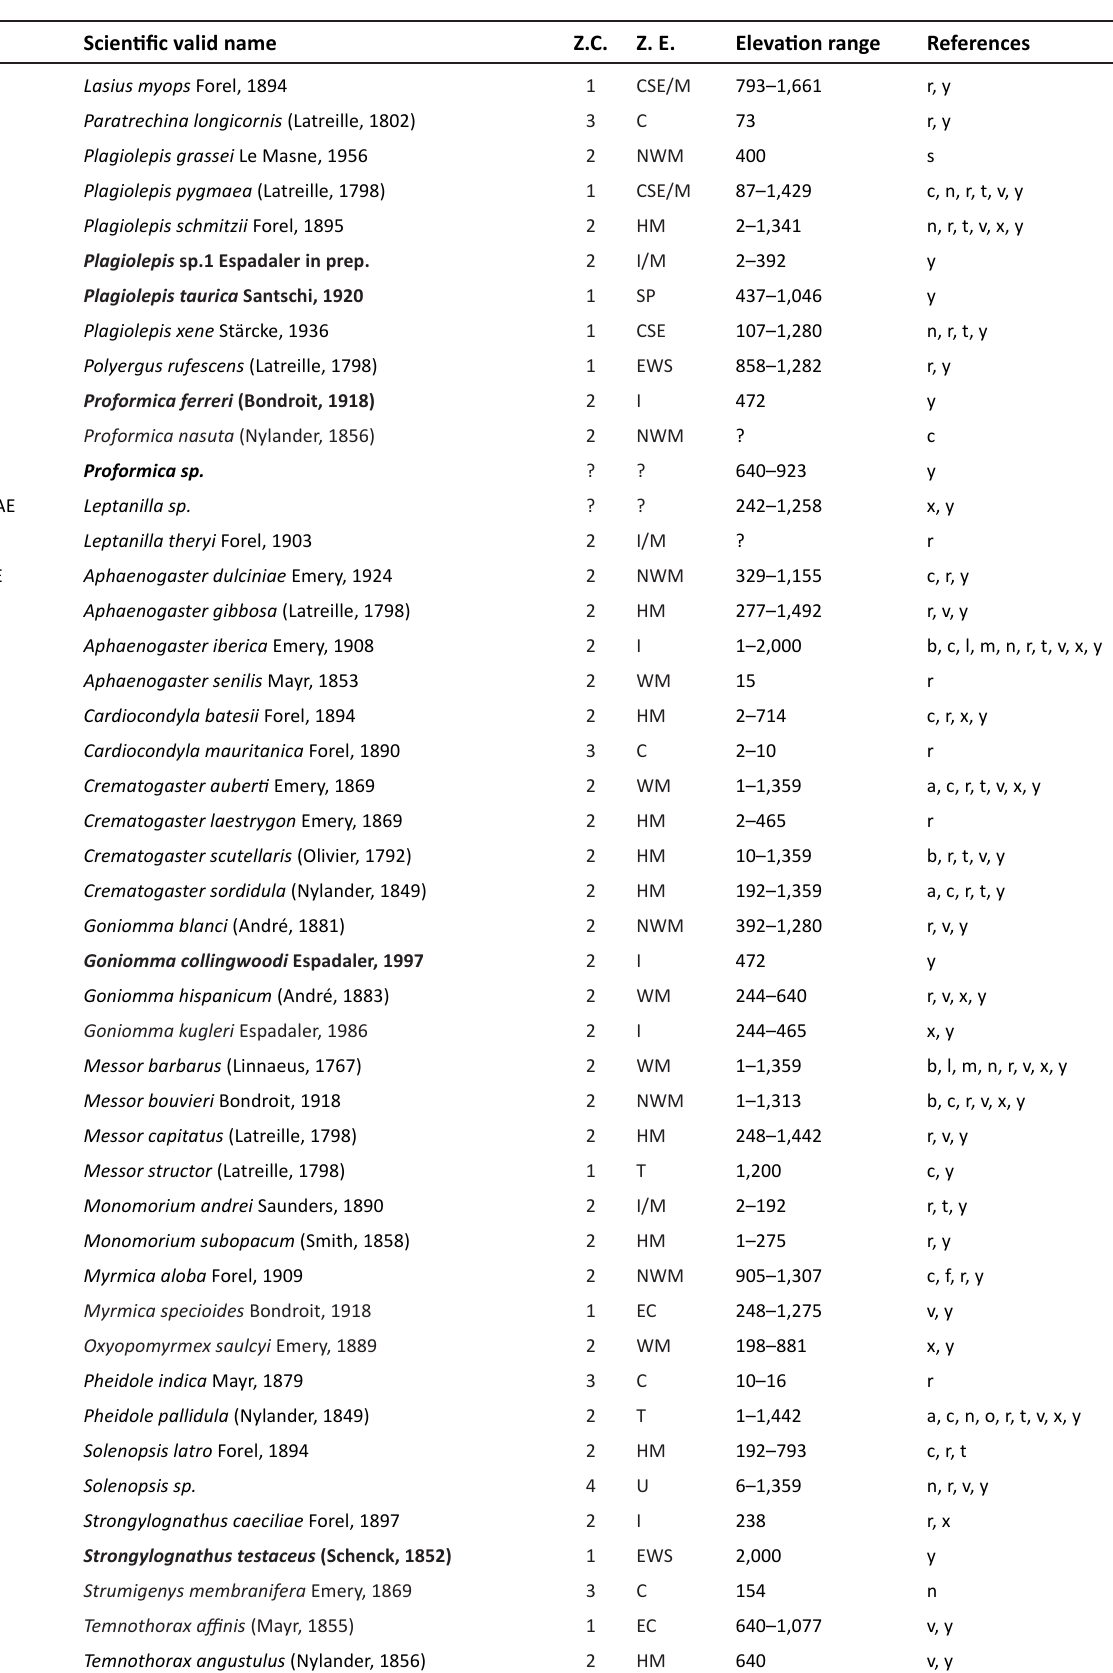
Table 1. Checklist of the ant species of the Segura River Basin. The list is arranged alphabetically by subfamily, genus and species. Species names in bold characters refer to species recorded for the first time in this area. (Continuation)